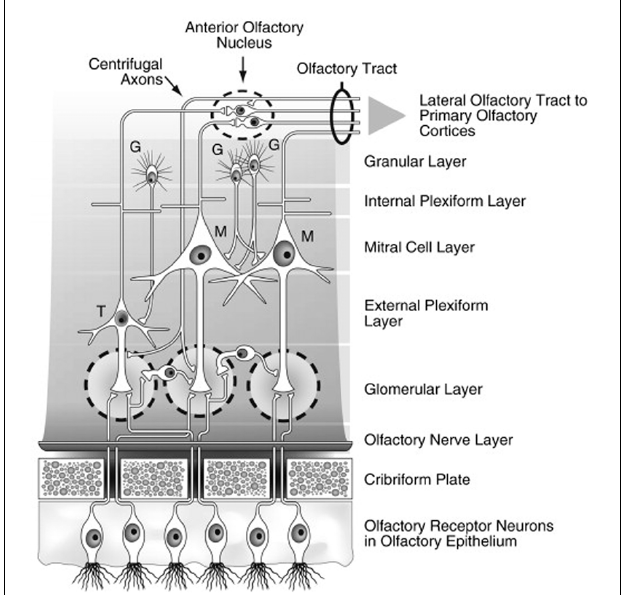
FIGURE 2 | Schematic drawing of the major layers of the olfactory bulb and the interactions between the different types of bulbar cells. Abbreviations: G, granule cells; M, mitral cells; T, tufted cells. Note that the largely GABAergic granule cells send projections into the mitral cell and external plexiform layers, and that some small cells extend projections into more than one glomerulus. Reprinted with permission from Duda (2010), with permission. Copyright©2010, Elsevier